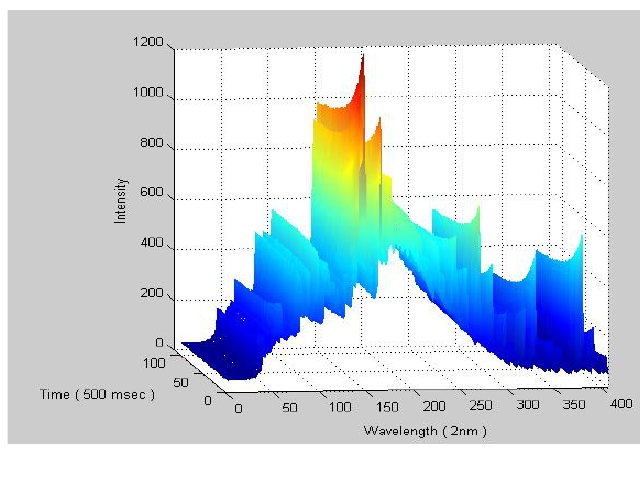
Figure 7. Spectrum data integrated with